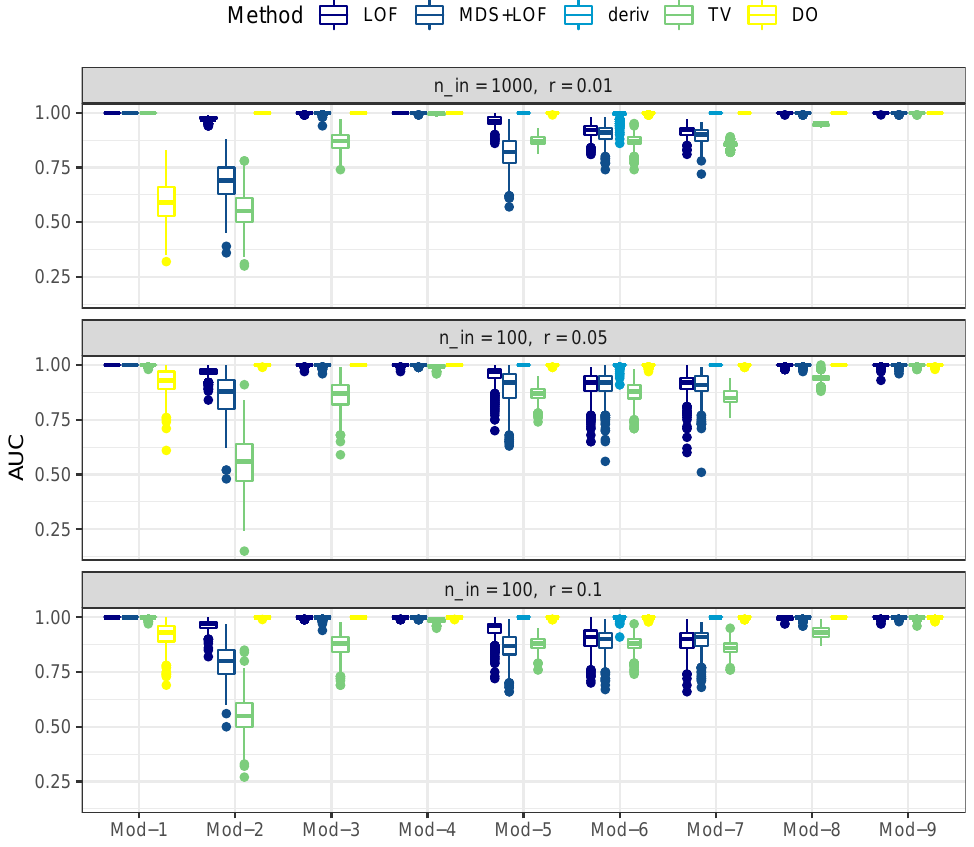
Figure A3. Distribution of the AUC over the 500 replications for the different outlier-detection methods, simulation models (Mod) from the package fdaoutier, and outlier ratios r